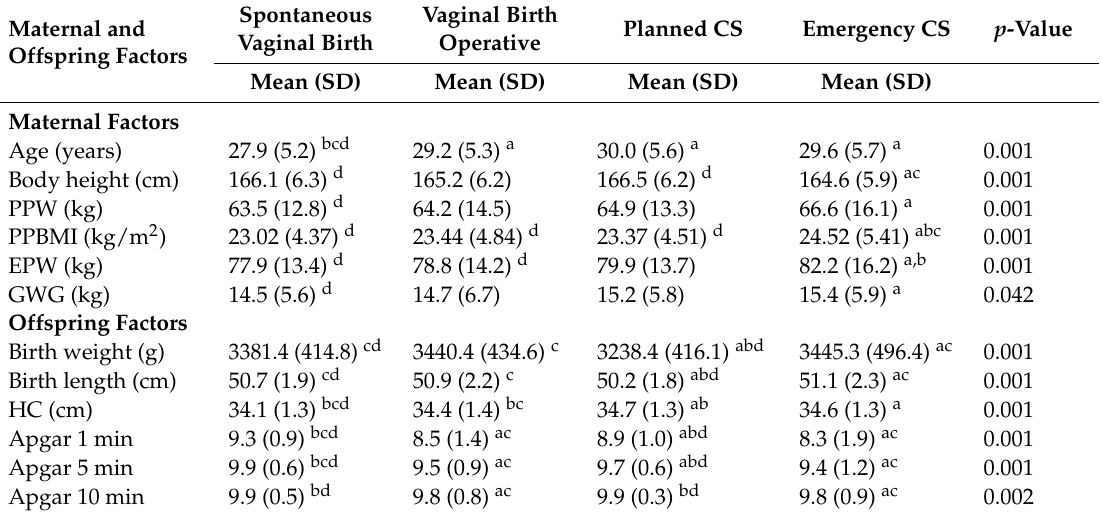
Table 3. Maternal and newborn characteristics according to delivery mode (ANOVA, Bonferroni post hoc test).